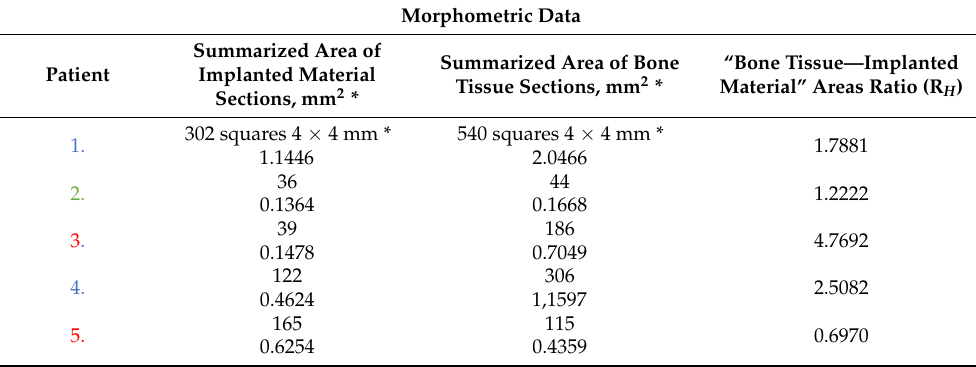
Table 5. Morphometric data of the patients for the examined hydroxyapatite (HAP-composite) specimens that were implanted. (in green/ blue are the ‘succesfull’ patients and in red the ones that have augmentation